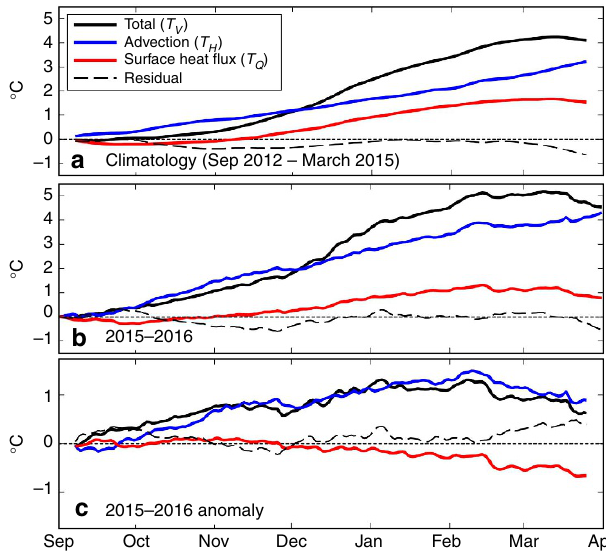
Figure 6 | Temperature budget during the 2015/16 MHW. ( a ) The climatology of the volume-averaged (0–100m, SEAus region) temperature ( T V , black line) along with contributions due to horizontal advection ( T H , blue line), air–sea heat flux through the surface ( T Q , red line) and the residual (dashed line). The climatology was calculated over three consecutive September–March periods (2012/13, 2013/14, 2014/15). ( b ) The temperature budget, as in a , but for 2015/16 only. ( c ) The anomalous temperature budget during 2015–2016, calculated as the difference between b , a (Fig. 6a, blue, red and black lines), with a small residual (dashed line, typically less than 0.5 (cid:2) C). Climatologically, by mid-February advection contributed B 60% of the warming while air-sea heat flux contributed B 40% of the warming.